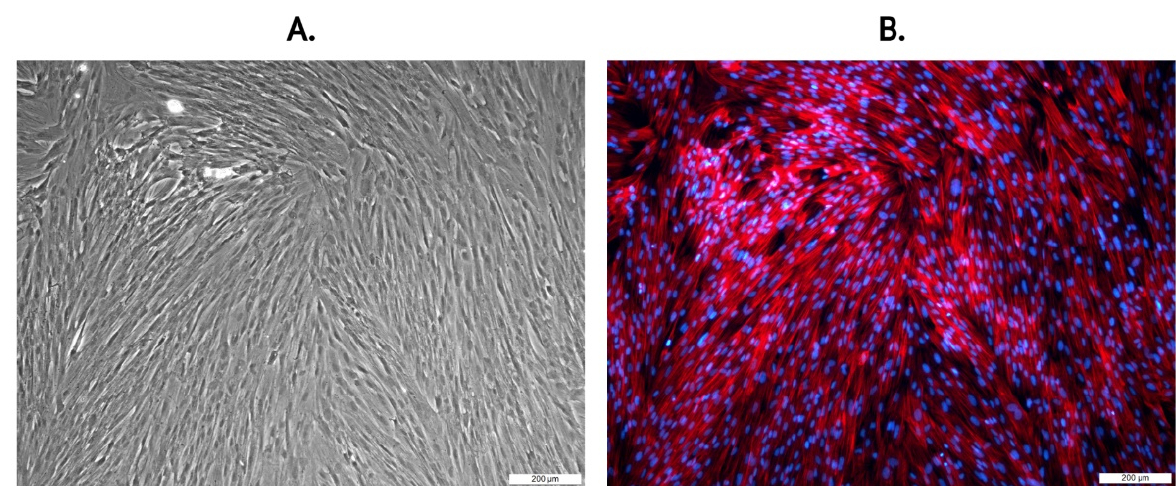
Figure 2. Morphology of CHo-MSCs in passage P4. ( A ) . Bright-field ( B ) . CHo-MSCs were stained with phalloidin (TRITC-conjugated fluorophore that labels actin microfilaments, red) and DAPI (fluorophore that labels nuclei, blue). The samples were imaged on an inverted fluorescence microscope Leica DMI3000B using a 10× objective. Scale bars = 200 µm.